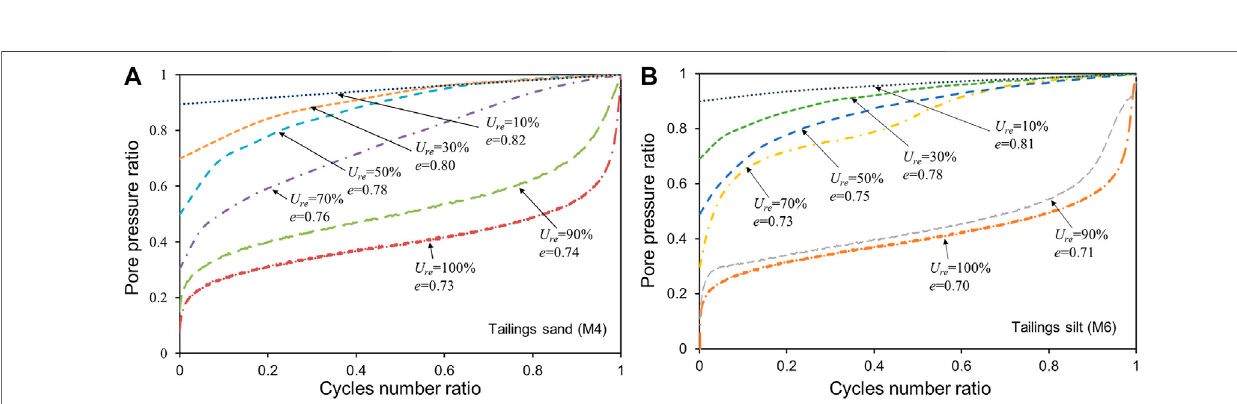
Table 4 . All the goodness-of- fi t of the six groups of test results